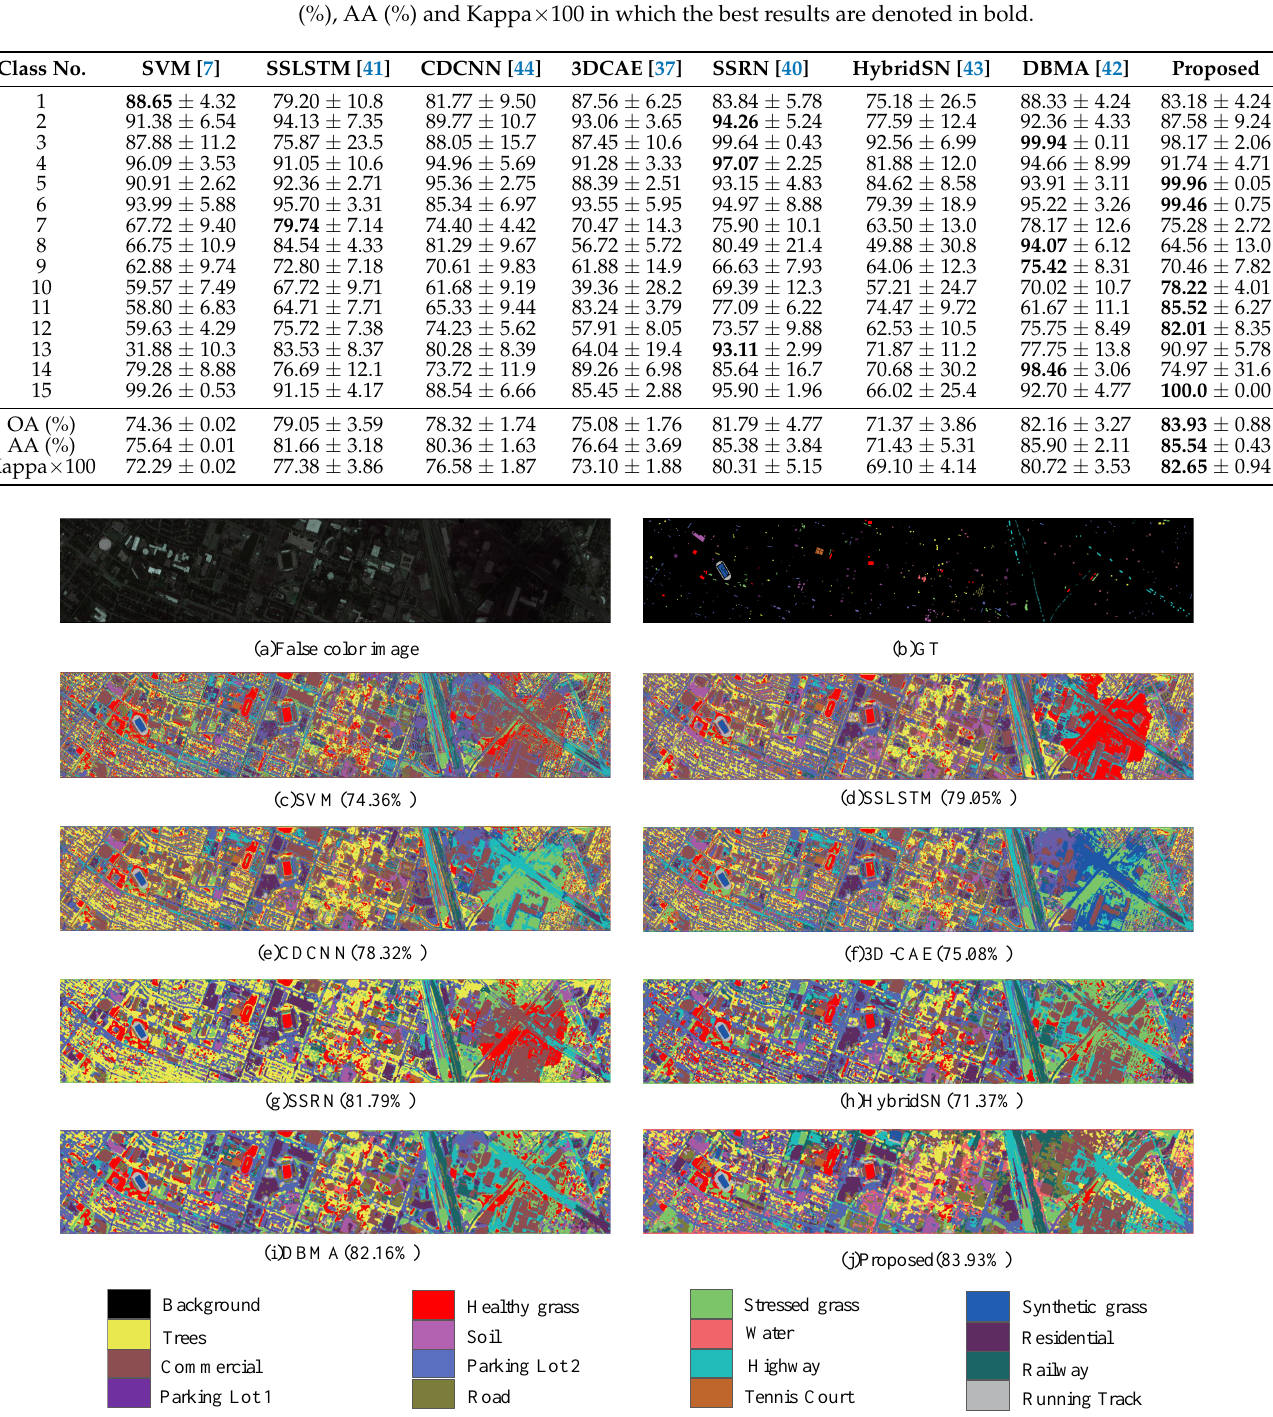
Figure 7. The classification maps of the Houston 2013 with 10 labeled